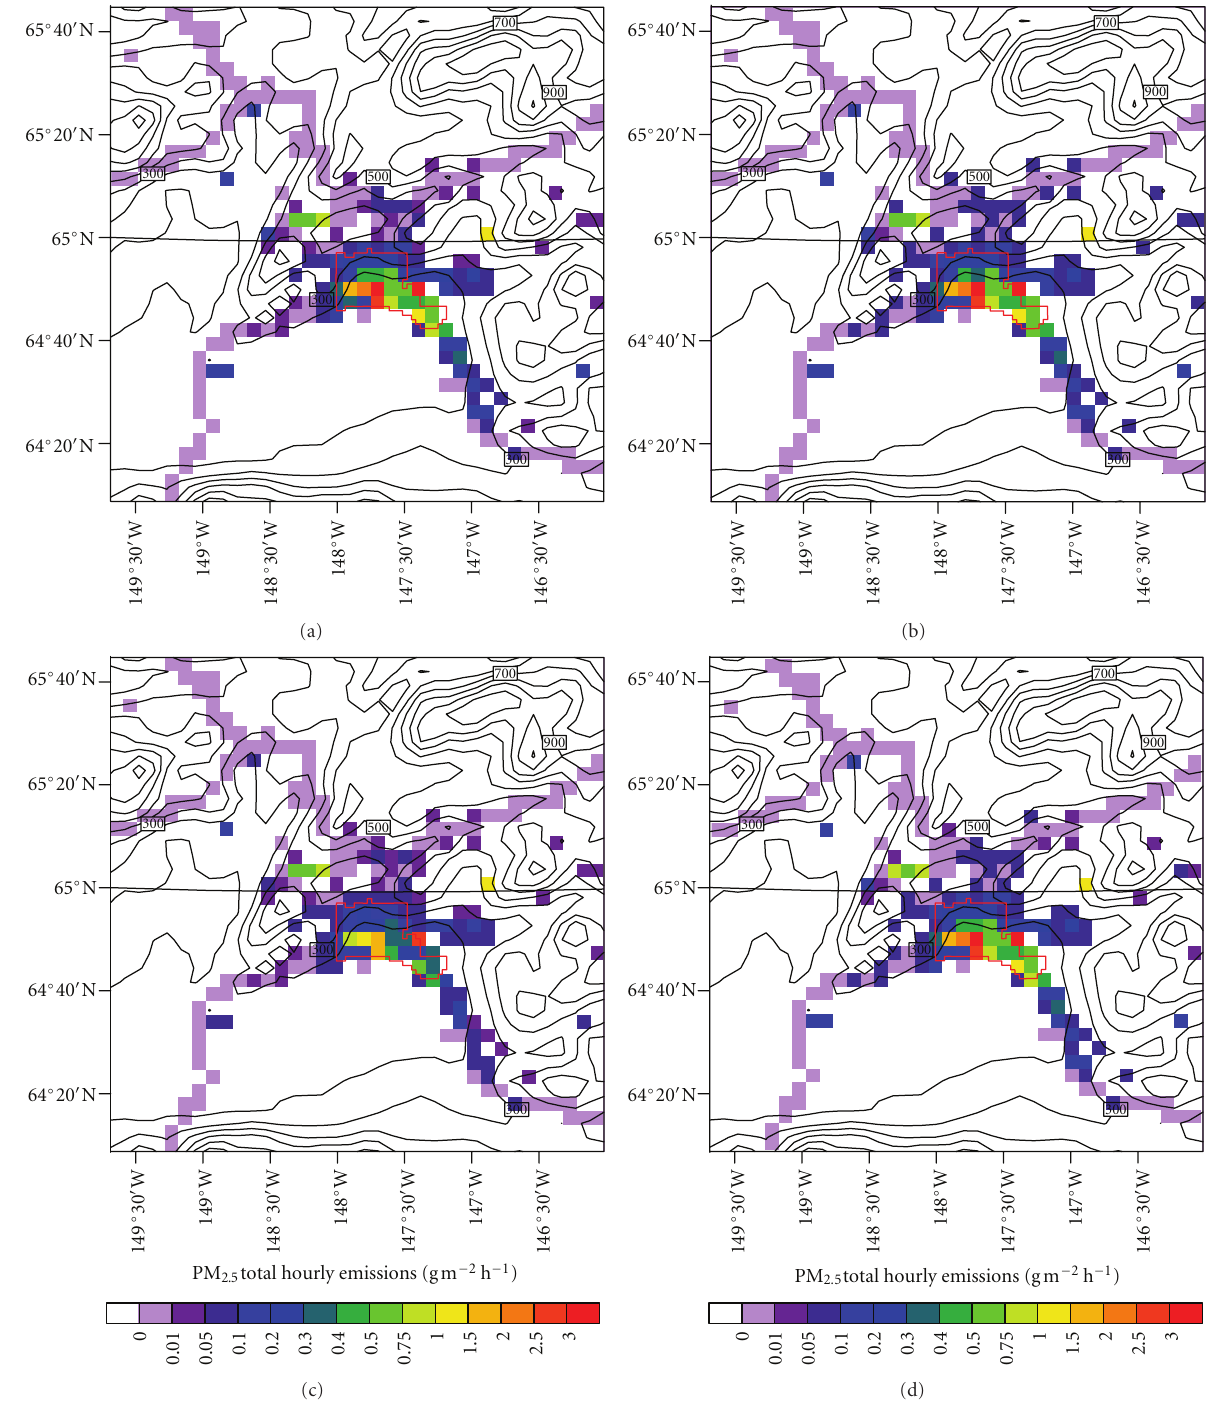
Figure 2: Zoom-in on PM 2 . 5 emissions in (a) REF, (b) WSR, (c) WSS1, and (d) WSS2 on average over October to March for REF and WSR and October 01–14, 2008, for WSS1 and